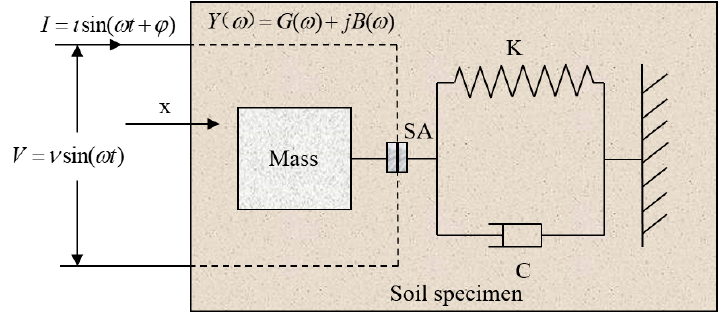
Figure 1. The electromechanical impedance model of a Lead Zirconate Titanate (PZT)-driven structural system.